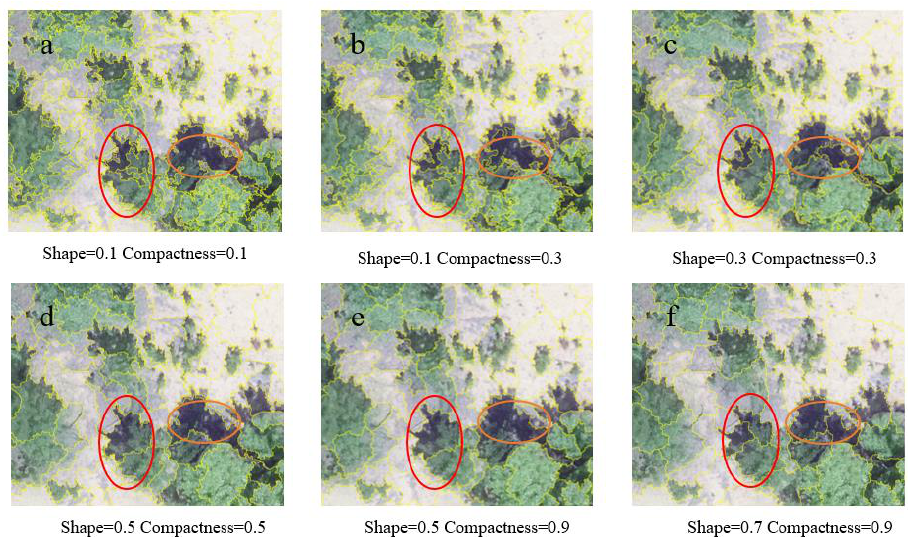
Figure 3. Effect of image segmentation for different segmentation parameters under the object-oriented method. ( a ) Segmentation effect with shape factor and compactness factor set to 0.1 and 0.1; ( b ) Segmentation effect with shape factor and compactness factor set to 0.1 and 0.3; ( c ) Segmentation effect with shape factor and compactness factor set to 0.3 and 0.3; ( d ) Segmentation effect with shape factor and compactness factor set to 0.5 and 0.5; ( e ) Segmentation effect with shape factor and compactness factor set to 0.5 and 0.9; ( f ) Segmentation effect with shape factor and compactness factor set to 0.7 and 0.9.